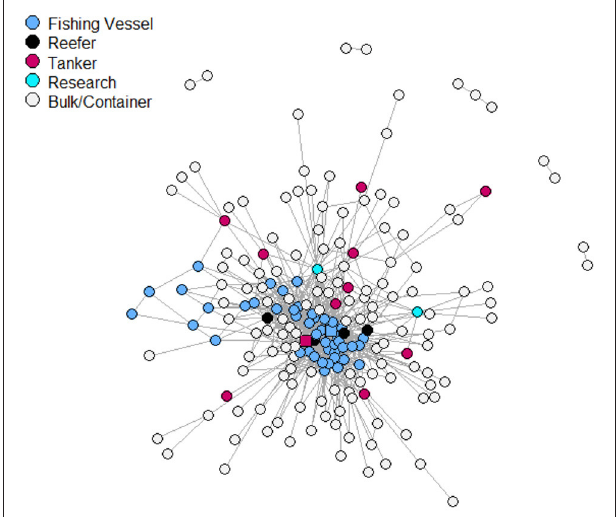
FIGURE 1 | Network plot of all 181 vessels in the region. Most central node is indicated by a red square, and most central fishing vessel by a blue square.